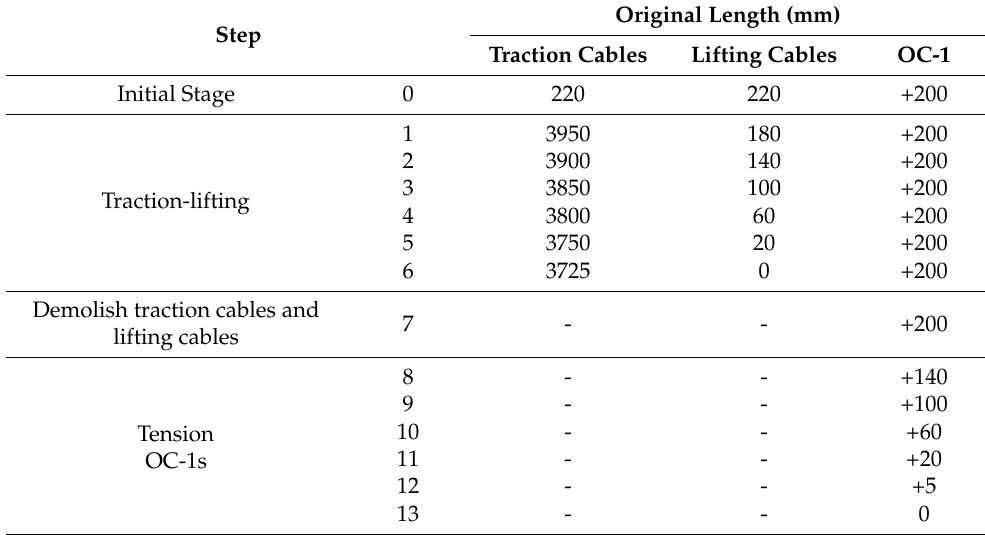
Table 3. Analysis steps of the construction process and lengths of different cables after